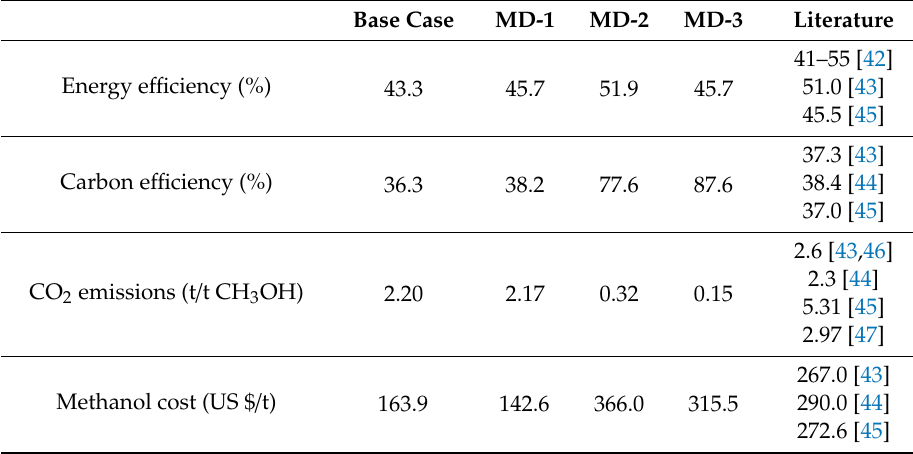
Table 5. Comparison of key results with the literature